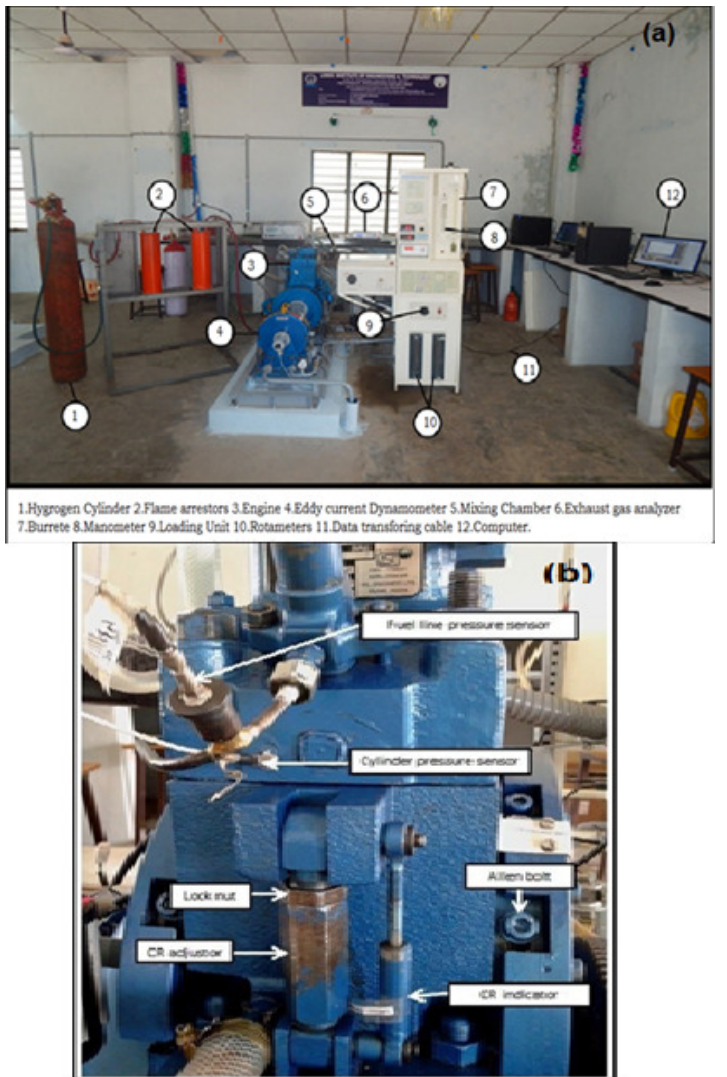
Figure 3. Photographic view of the experimental test rig of Diesel Engine a) Accessories and Diesel Engine b) Components of Diesel Engine.